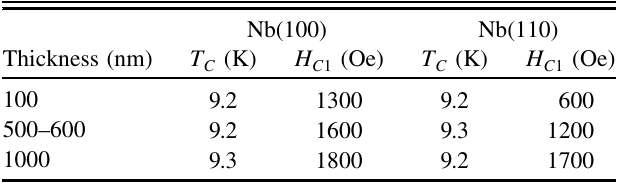
TABLE I. Summary of superconducting properties. T C values were measured with an applied field of 50 Oe. H C measured at 4 K.